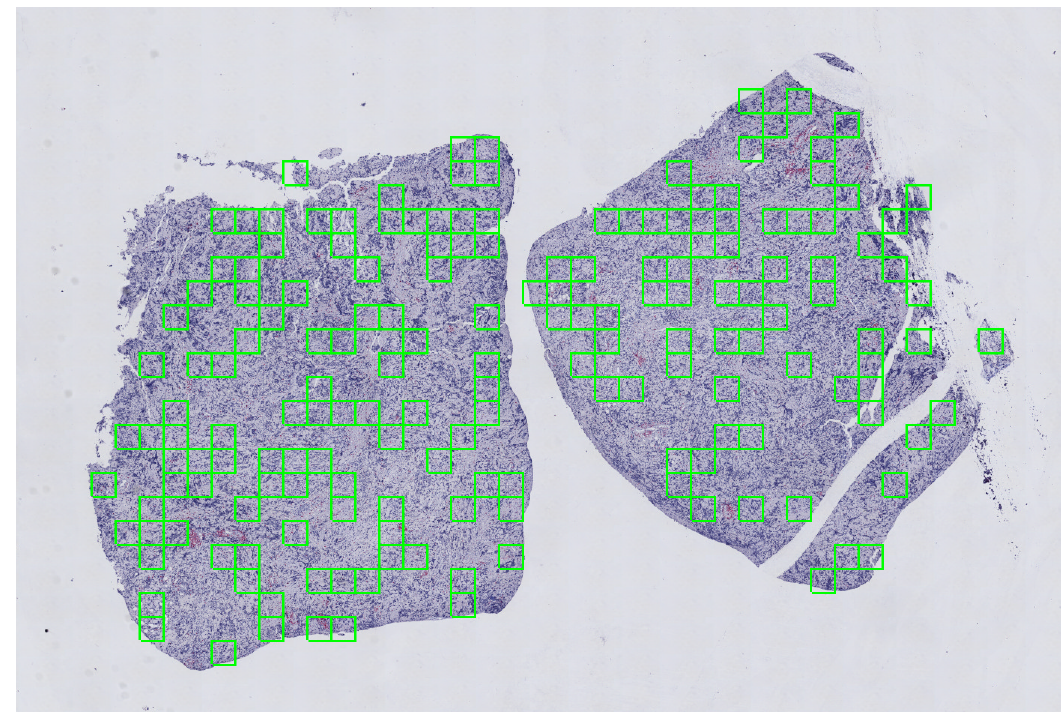
Figure 20. Visualization of the random extraction pattern for the tile extraction in a grid-like fashion. A portion of an CD3+ stained WSI used for the NeSTBG dataset is portrayed (at magnification 1.25 × ). The size of each tile is representative of the real portion of tissue captured with a 512 × 512 tile at 20 × magnification.